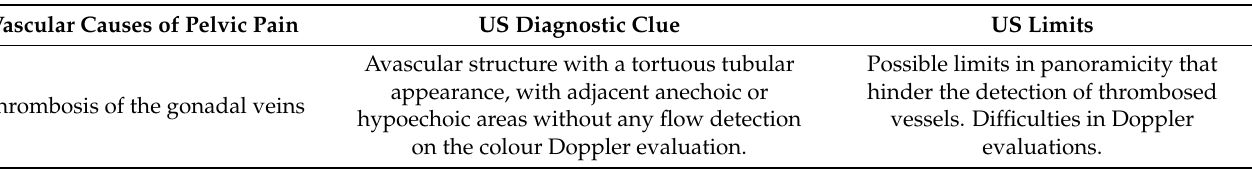
Table 13. Thrombosis of the gonadal veins US diagnostic clue. Vascular Causes of Pelvic Pain US Diagnostic Clue US Limits Avascular structure with a tortuous tubular appearance, with adjacent anechoic or Thrombosis of the gonadal veins hypoechoic areas without any flow detection